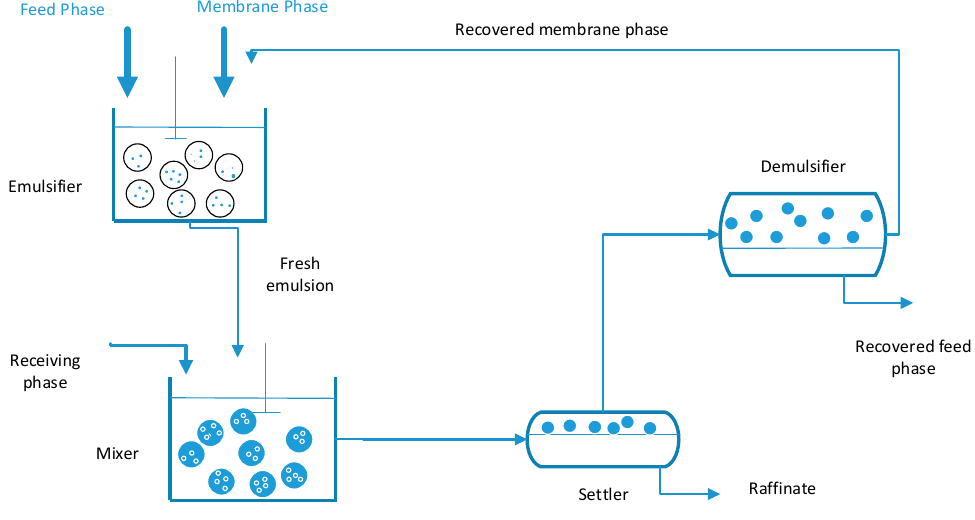
Figure 18. Emulsion liquid membrane